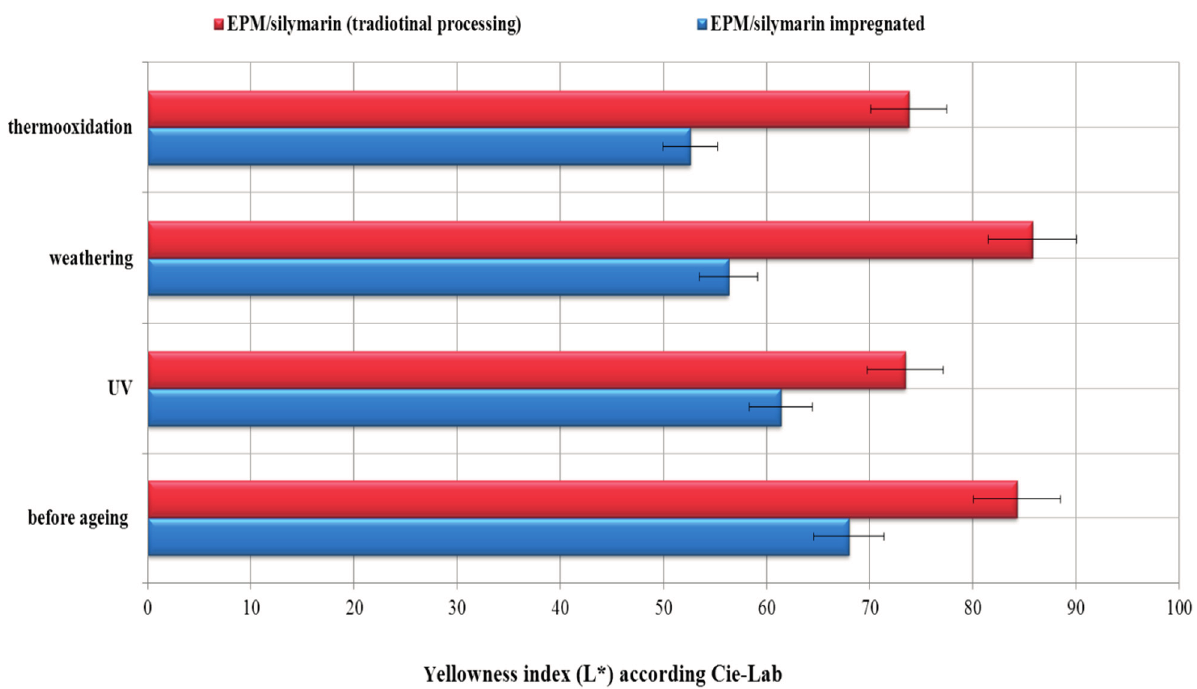
Figure 6. Effect of silymarin (10%) on the color of the EPM material. L index ( L *—level of light or dark over the range 0–100) tested in the CIE-Lab coordinate space.